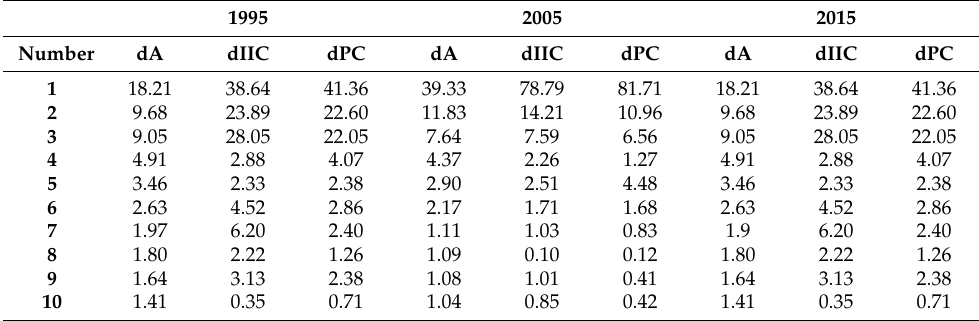
Table 4. Top 10 patch importance index ranking results from 1995 to 2015 in Zhongshan